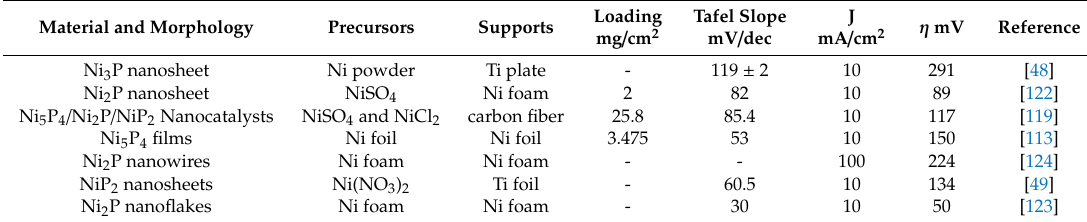
Table 6. Summary of the nickel phosphide electrocatalysts prepared through thermal phosphidation with red phosphorus for HER in an alkaline